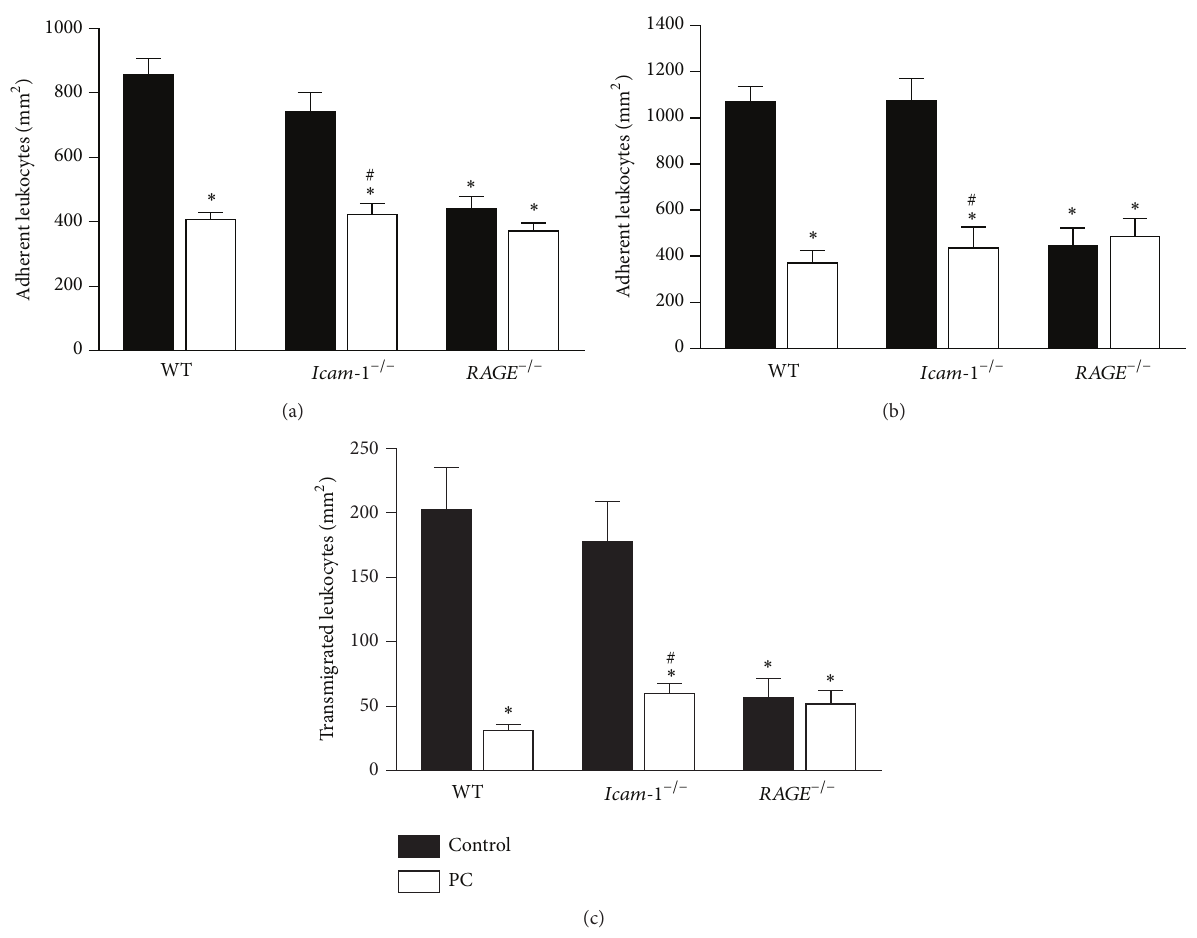
Figure 2: Effect of PC on leukocyte recruitment in wild-type, RAGE −/− , and Icam-1 −/− mice after TNF 𝛼 stimulation. Leukocyte adhesion (number of adherent cells per mm 2 of surface area) in 3h TNF 𝛼 -stimulated (500 ng/mouse) cremaster muscle venules of wild-type (WT) control mice and Icam-1 −/− and RAGE −/− mice was documented with and without treatment with PC (100U/kg, 3 hours) (a). Leukocyte adhesion in the same genotypes and treatment groups was depicted after additional stimulation with fMLP (superfusion at 1 𝜇 M, 5min) (b). Leukocyte transmigration (per mm 2 surface area) was analyzed in Giemsa-stained cremaster muscle whole mounts after 5 min fMLP superfusion (1 𝜇 M) in the TNF 𝛼 -model in WT, Icam-1 −/− , and RAGE −/− mice with and without PC treatment (100U/kg, 3 hours) (c). All values are presented as mean ± SEM from three or more mice per group. Significant differences ( 𝑃 < 0.05 ) to WT and Icam-1 −/− control mice are indicated by the asterisks and pound key,